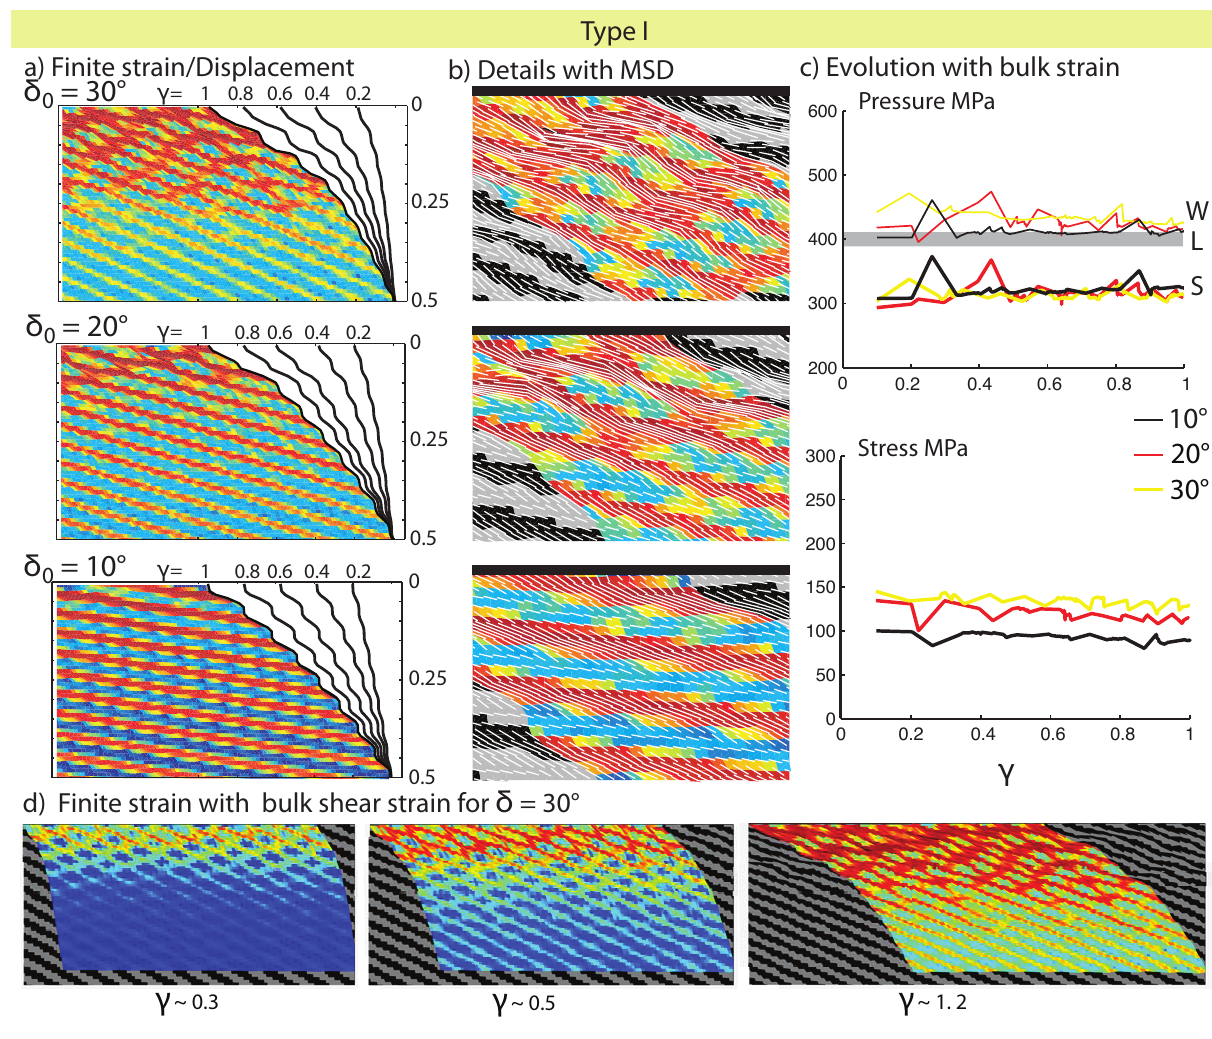
Fig. 4. Type I (a) Colour scale indicates strain intensity. Most of strain concentrates in weak layers and increases in strong layers as obliquity increases. Depth-displacement profiles (solid black lines) indicate no localisation of deformation beneath detachment with rising bulk strain. (b) MSD (white lines) indicates coaxial stretching of strong layers and shearing of weak layers. (c) Evolution of pressure and deviatoric stress for weak (W, thin lines) and strong (S, thick lines) suggest stationary stress and a pressure gap between strong and weak layers. Applied lithostatic pressure (L) is outlined by a thick grey line (d) . The evolution of finite strain with time for the δ 0 = 30 ◦ model suggests that distribution of strain rate with depth is aquired at an early